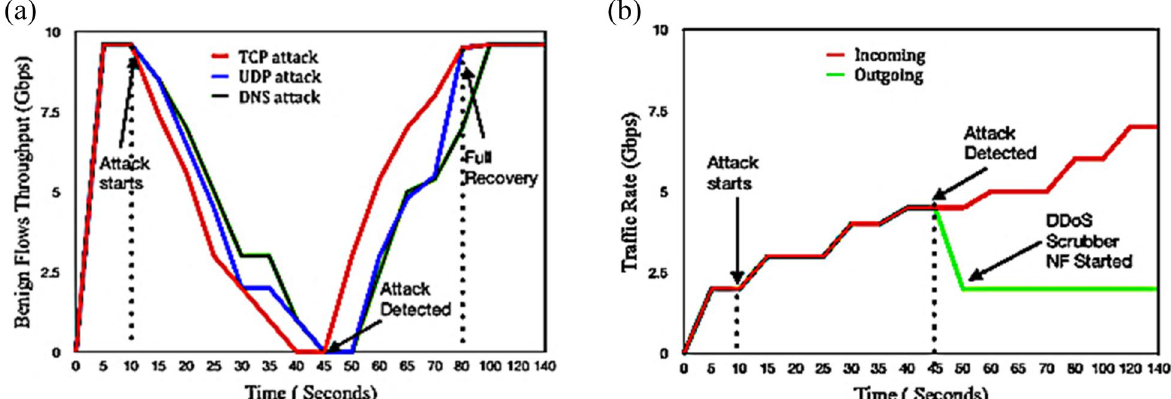
Fig. 28 a Dynamic DDoS detection b Dynamic NF insertion in